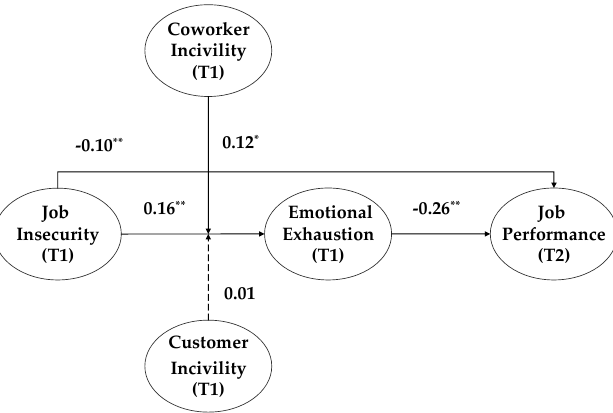
Figure 2. Moderated mediation model. Note: * p < 0.05, ** p < 0.01.